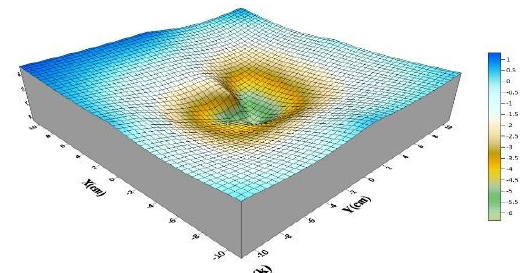
Fig. 7(o): The Scour and Deposition Pattern around Pier (P 1 ) at angle 19 0 and flowrate 18 L/Sec. The green area denotes maximum Scouring Pattern